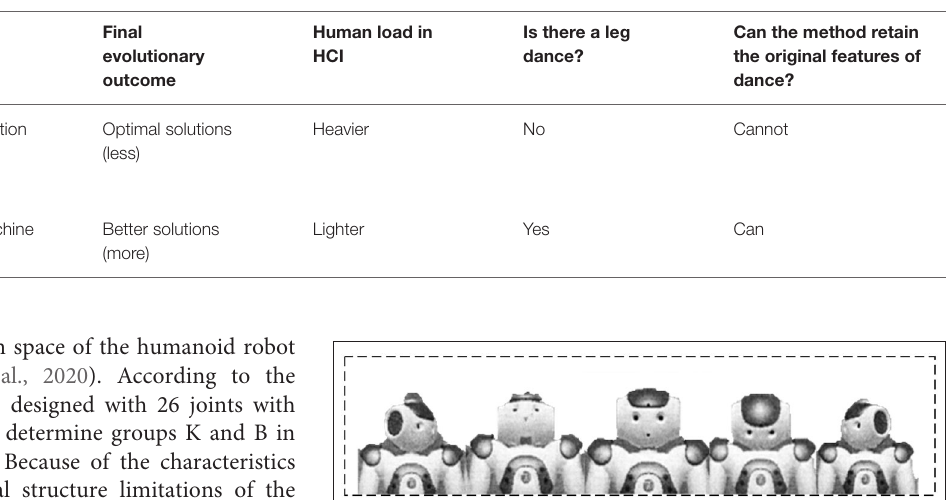
TABLE 2 | Comparison between the proposed model and IEC.